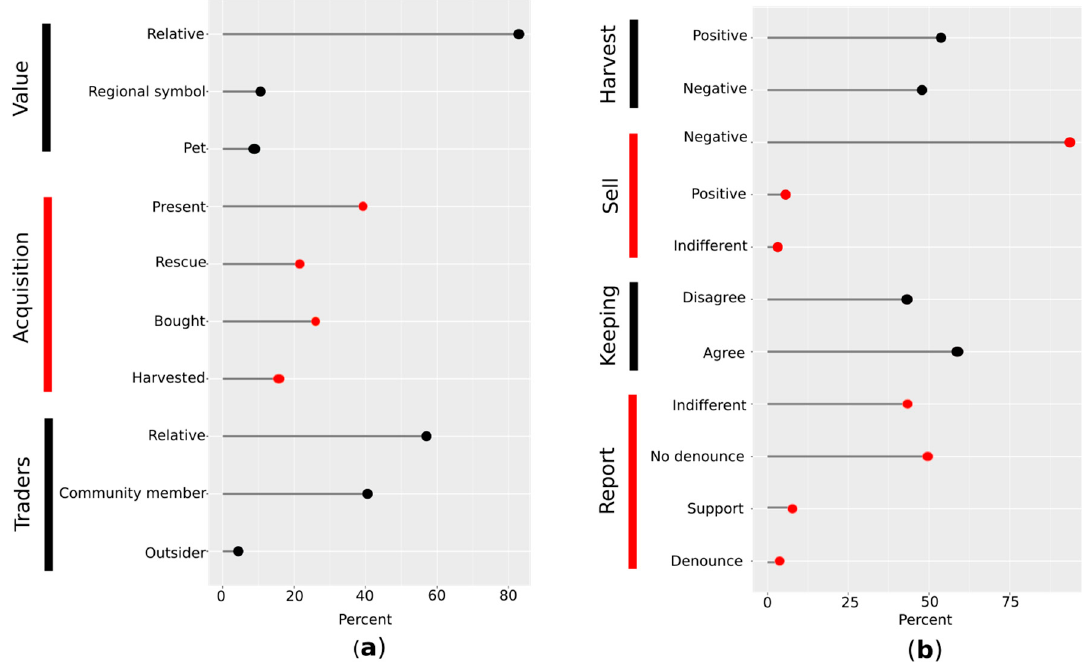
Figure 4. Social processes affecting conservation actions implemented by Provita’s yellow-shouldered Amazon Conservation Program in Macanao: ( a ) social values and ( b ) attitudes towards stages in the trade chain.